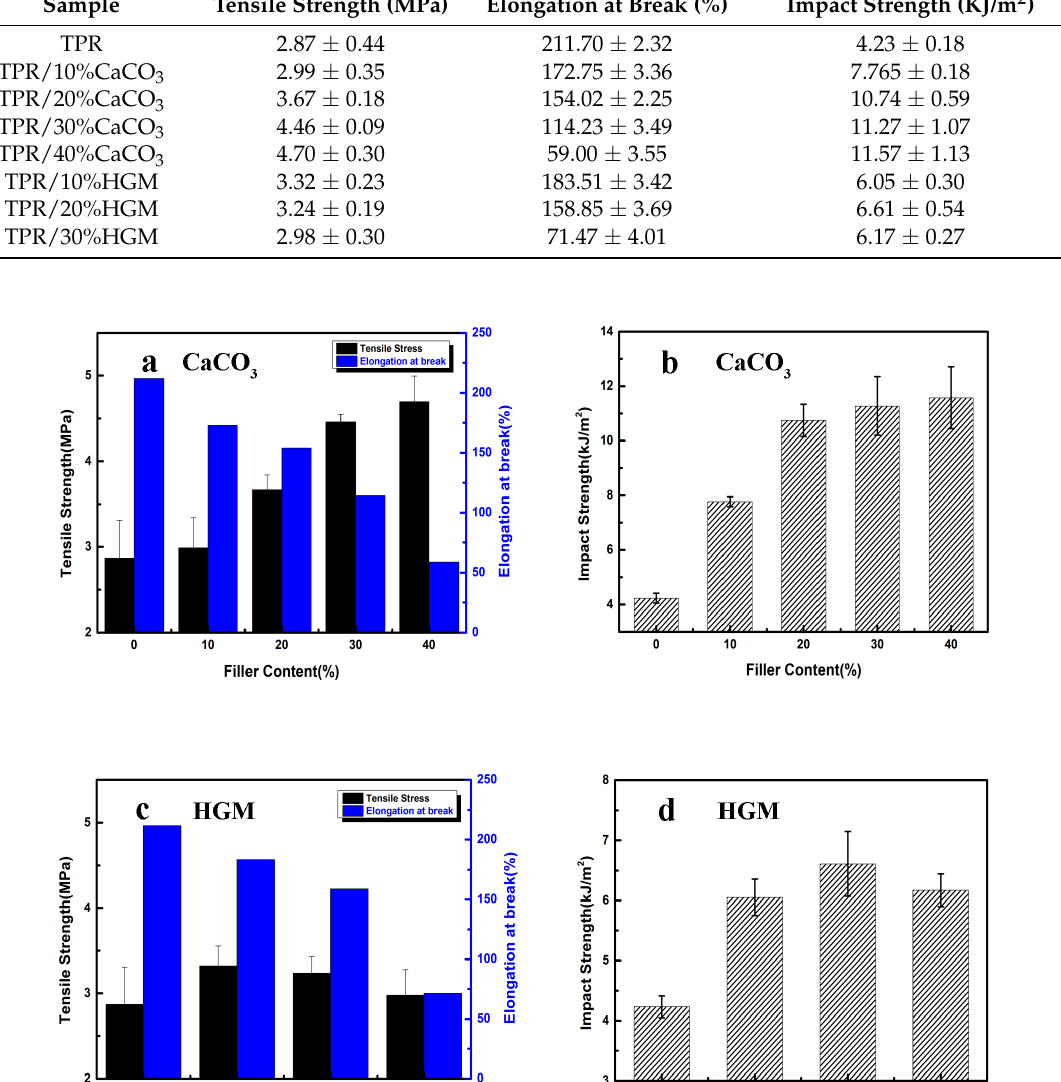
Table 3. The mechanical properties of TPR composites.